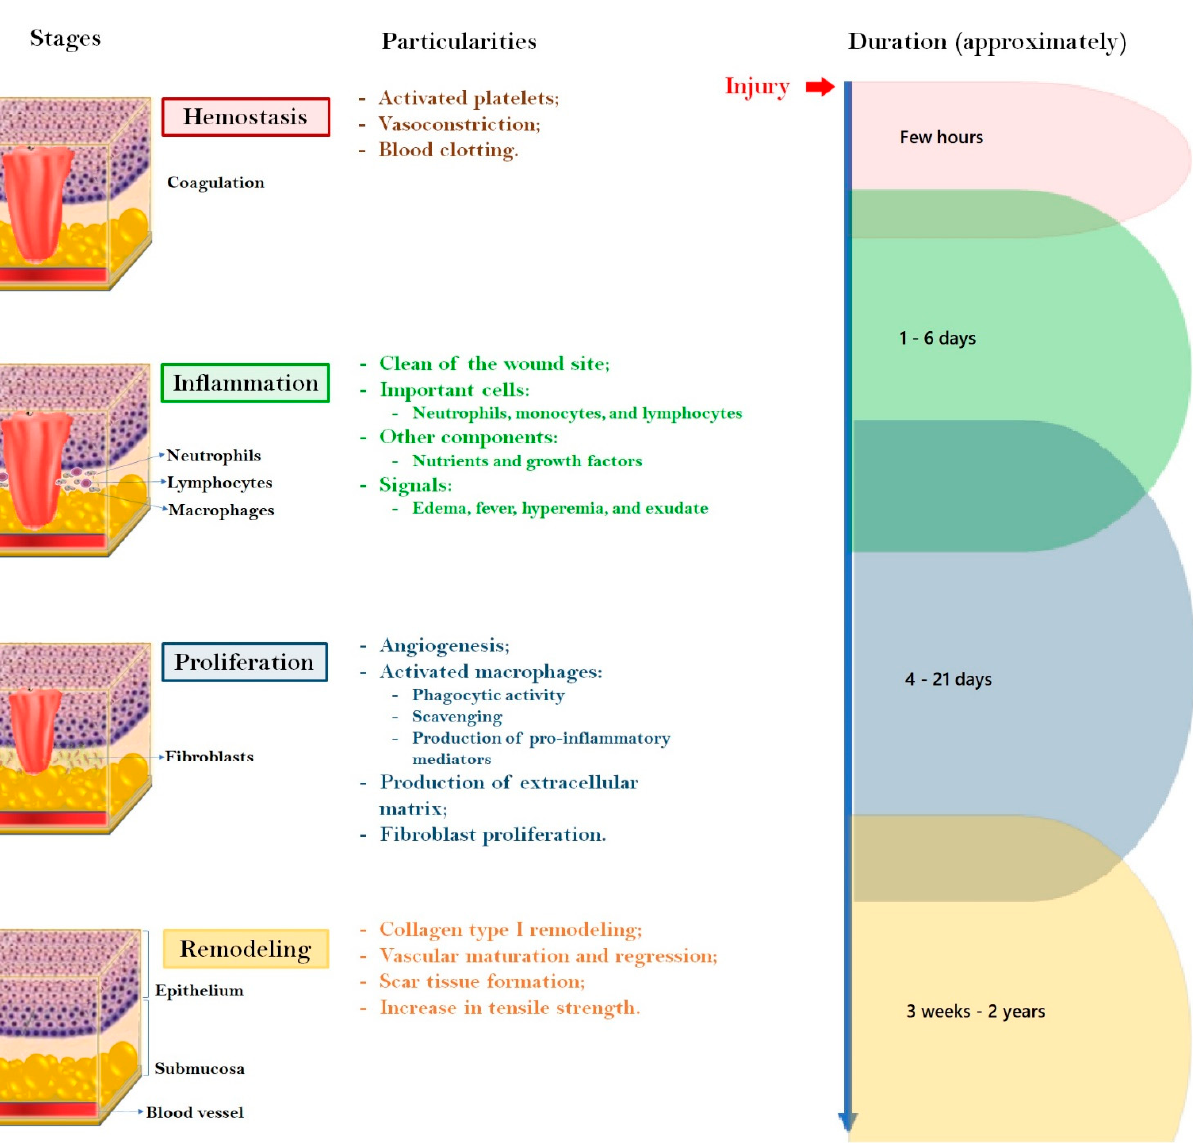
Figure 2. Normal physiological wound-healing process and particular characteristics of its four orchestrated stages (adapted from Albuquerque et al. [27]). orchestrated stages (adapted from Albuquerque et al.